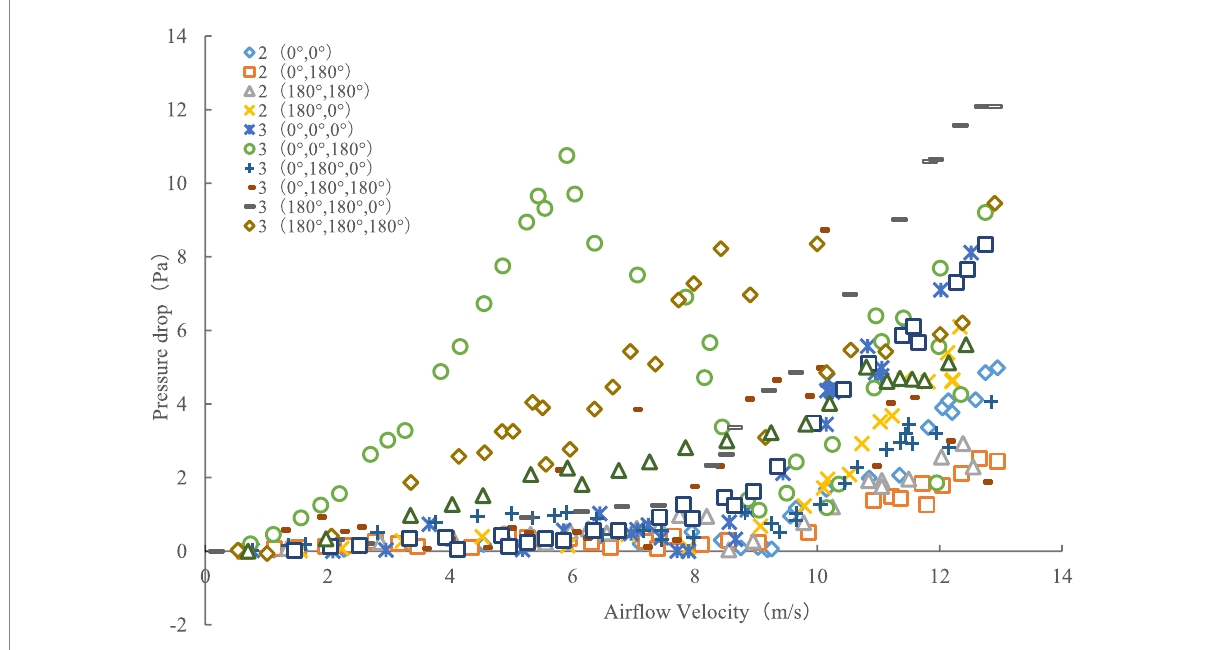
FIGURE 13 Variation of canopy pressure drop with air velocity with different numbers of leaf sample layers.